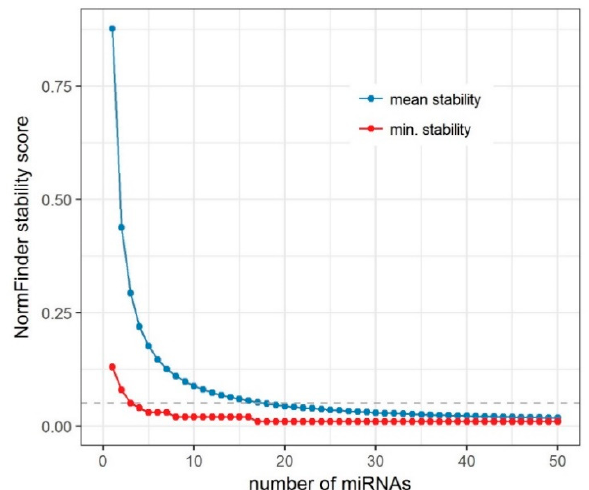
Figure 2. NormFinder stability scores relative to the number of miRNAs tested. For visualization purposes, we limited the plot to the results of the first 50 iterations. Beyond that point, no clear changes could be observed in the linear scale.